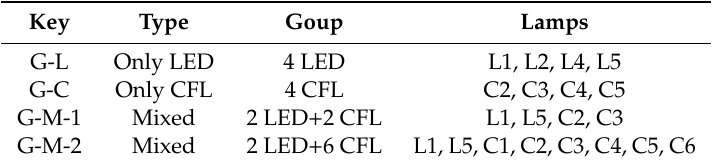
Table 2. Evaluated lamp